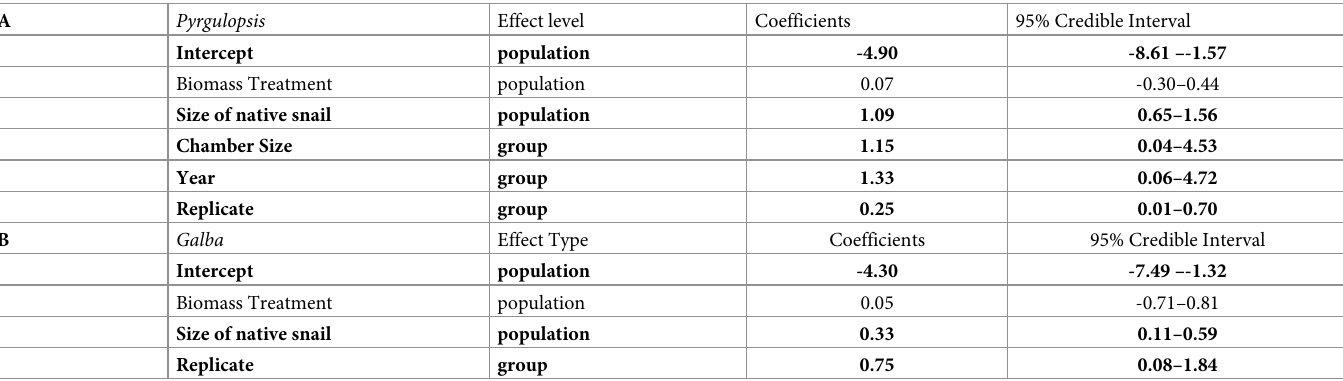
Table 3. Model coefficients and credible intervals for overall infection status. How infection status (all trematodes combined) was affected by biomass of Potamopyrgus (Biomass Treatment: Control, with no Potamopyrgus , ambient levels of Potamopyrgus in Polecat Creek, and High biomass) for two taxa of native snails in Bayesian multi- level models [39, 40]. For the native snail Pyrgulopsis (A ) , the group level effects were the year that the experiment was conducted (year), the size of the experimental cham- ber (chamber size) and the experimental replicate (replicate) nested within Treatment. Because we only tested the dilution effect hypothesis with the native snail Galba (B) in one year and with all the same sized experimental chambers, the group level effect for Galba was replicate. Variables that significantly affected infection status possess 95% credible intervals that exclude zero and are bolded. For the group level effects, values in the Coefficients column are standard deviations for the Coefficient estimates.